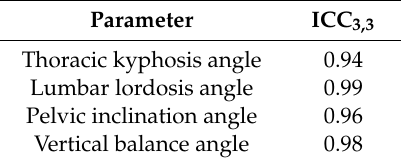
Table 2. Intraclass Correlation Coe ffi cient (ICC 3,3 ) for barefoot measurements.